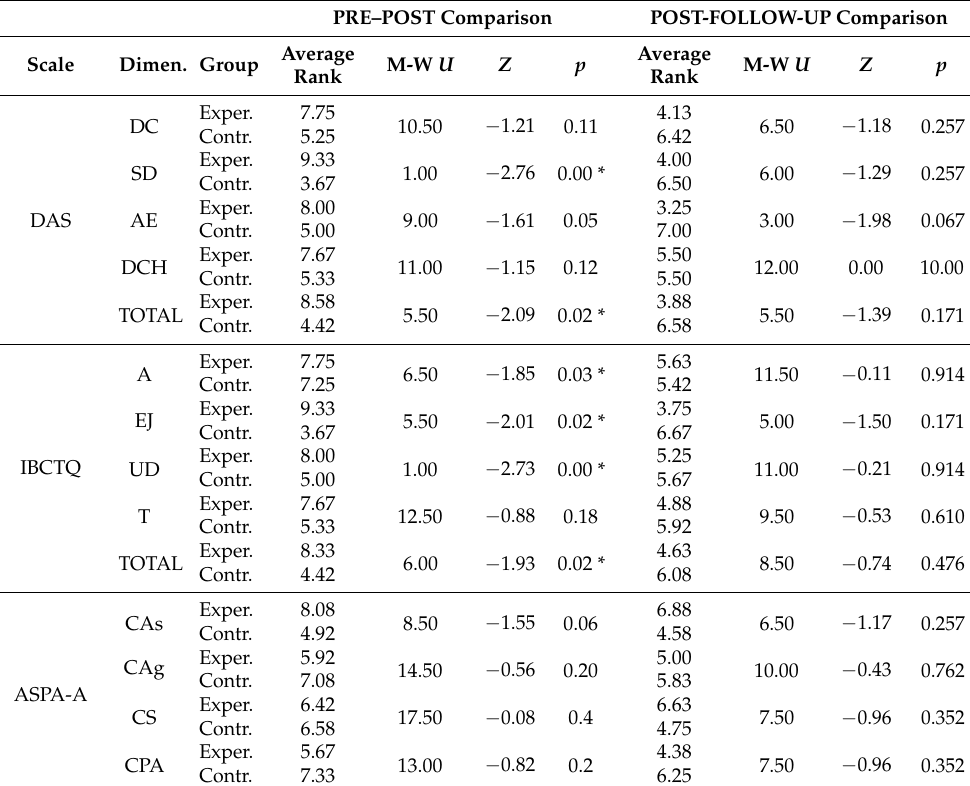
Table 4. Mann–Whitney, Z, and associated probability ( p ) results comparing pre–post and post- follow-up changes between experimental and control